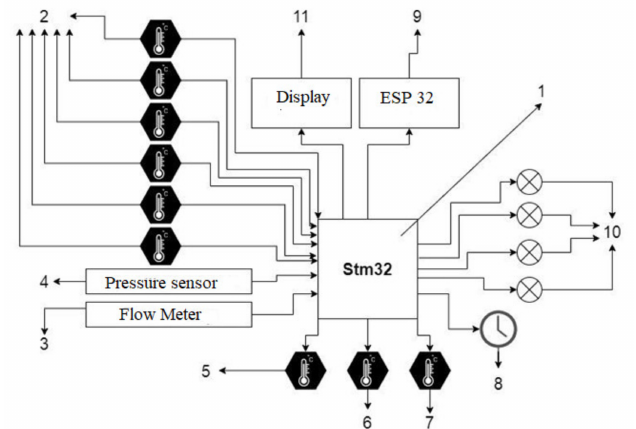
Figure 5. Block diagram for the control controller. ( 1 ) programmable logistics integrated circuit; ( 2 ) tem- perature sensor; ( 3 ) water flow sensor; ( 4 ) pressure sensor; ( 5 ) coolant temperature sensor in the heater tank; ( 6 ) coolant temperature sensor in the heat exchanger; ( 7 ) outdoor temperature sensor; ( 8 ) built-in software measuring device real-time; ( 9 ) ESP32 module; ( 10 ) four valves; ( 11 ) operation